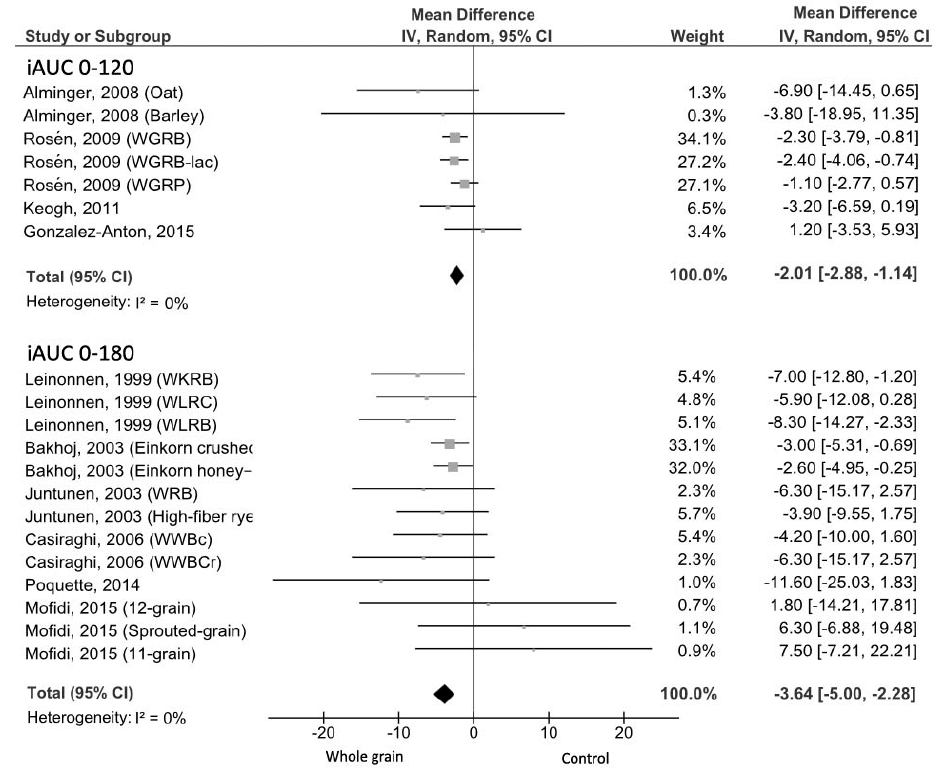
Figure 3. Forest plot of the meta-analysis carried out to investigate the effect of whole grain consumption on insulin iAUC. iAUC: incremental area under the curve; WGRB, whole grain rye bread; WGRB-lac, whole grain rye bread with lactic acid; WGRP, whole grain rye porridge; WKRB, whole kernel rye bread; WLRB, wholemeal rye bread; WLRC, wholemeal rye crispbread; WRB, Whole rye bread; WWBc, whole-wheat cookies; WWBCr, whole-wheat crackers.